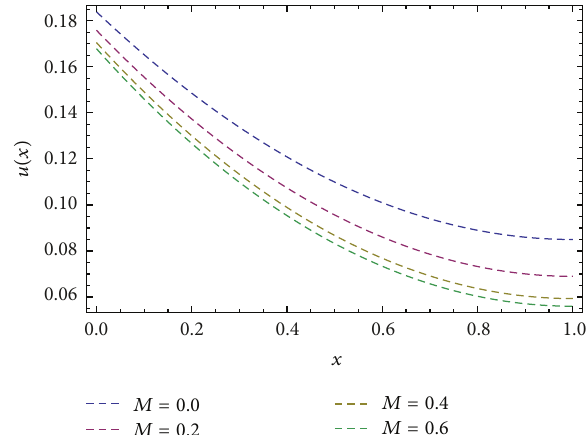
Figure 6: The effect of magnetic force “ 𝑀 ” on the lift velocity profile keeping other parameters fixed. 𝛼 = 0.1 , 𝑚 = 0.2 , 𝛽 = 1.2 , and Λ = 0.4 .